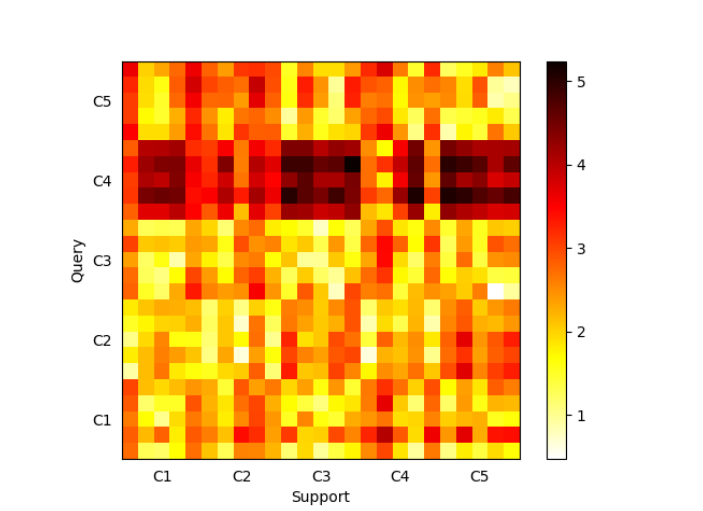
Figure 8. Visualization on DBLP (raw